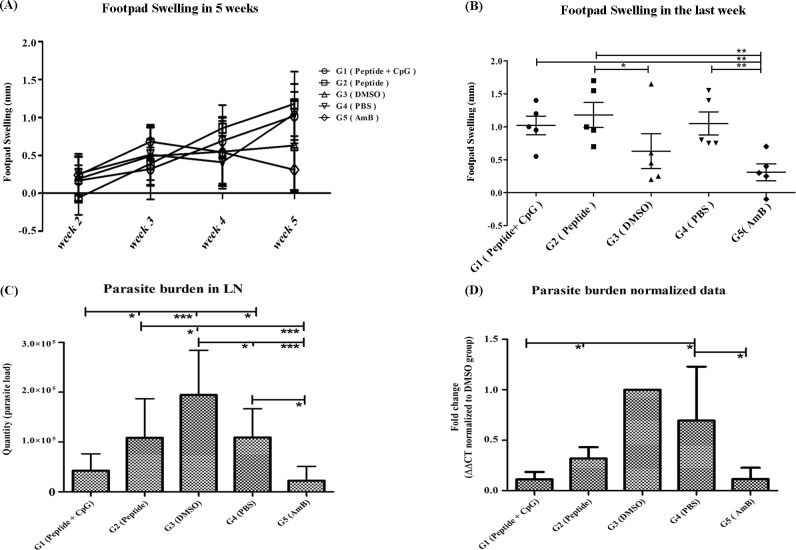
(A) Footpad swelling in weeks after challenge until the end of treatment. Swelling was calculated according to thickness and width of the footpad. Infected foot size was subtracted from intact footpad. (B) Footpad swelling in experimental groups at 5th week after challenge. (C) Real-time PCR assay for parasite burden determination in the lymph node of experimental animals. Peptide (L- Brevinin 2R) with or without CpG motif was able to control the parasite load in the lymph nodes adjacent to the infected footpad. (D) Normalized data provided from GAPDH house-keeping gene Real- time PCR assay in parallel with parasite burden in lymph node samples. *, ** and *** = P value < 0.05, < 0.01 and < 0.001 respectively.